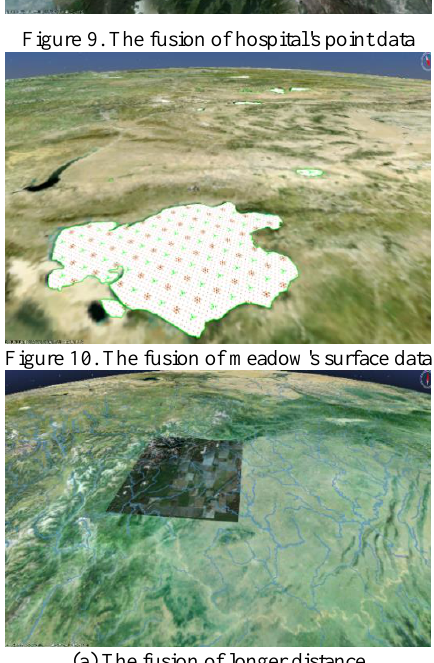
Figure 12. The trend with the number of threads